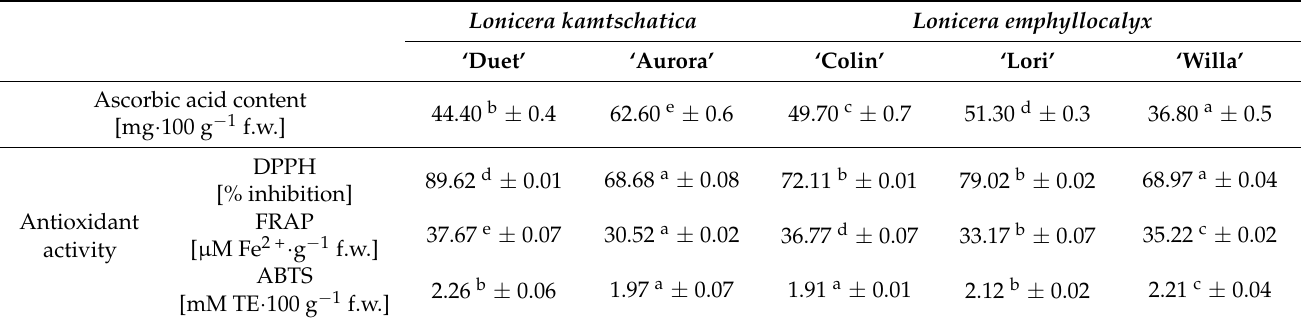
Table 1. Ascorbic acid content and antioxidant activity of L. kamtschatica and L. emphyllocalyx fruit. Lonicera kamtschatica Lonicera emphyllocalyx ‘Duet’ ‘Aurora’ ‘Colin’ ‘Lori’